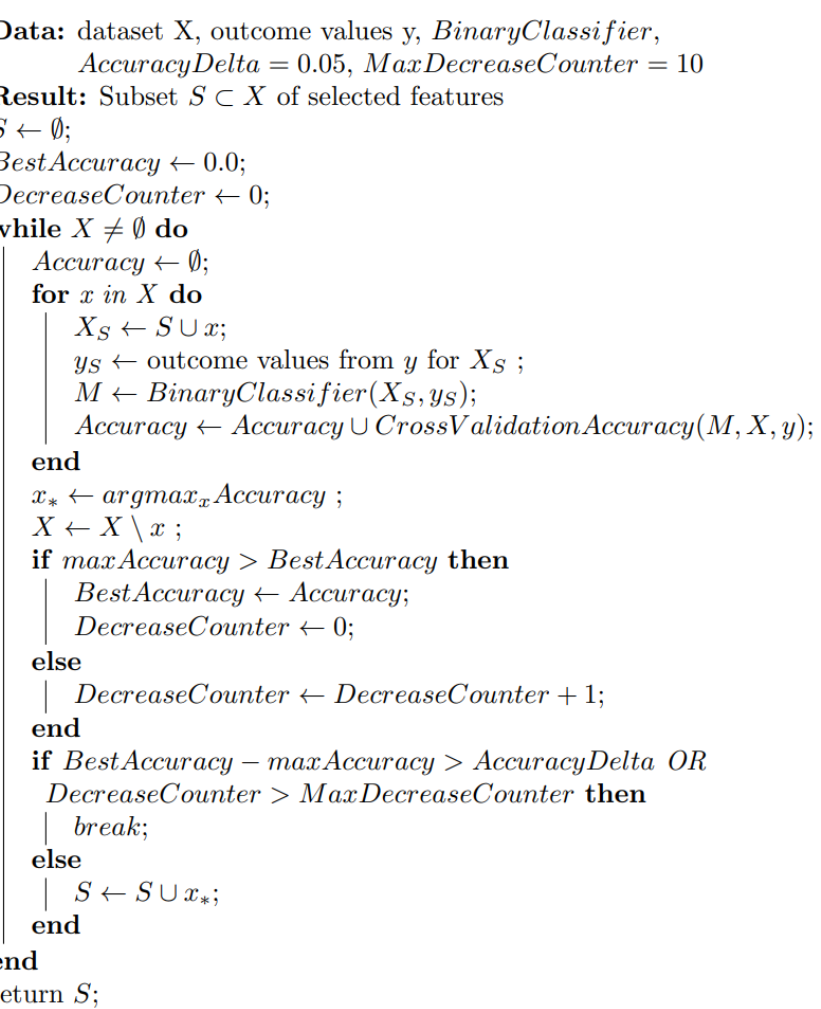
Figure 5. The algorithm of the cross-validation-based greedy selection procedure. The algorithm takes as inputs the following parameters: dataset X (gene features of each of three datasets, simple scaled, without correlated genes, and without co-expressed), BinaryClassifier (a function of binary classification), AccuracyDelta (the minimum significant difference in the accuracy score), and MaxDe- creaseCounter (the maximum number of steps to evaluate in case of accuracy decrease). The iterative feature selection procedure returns a subset of selected